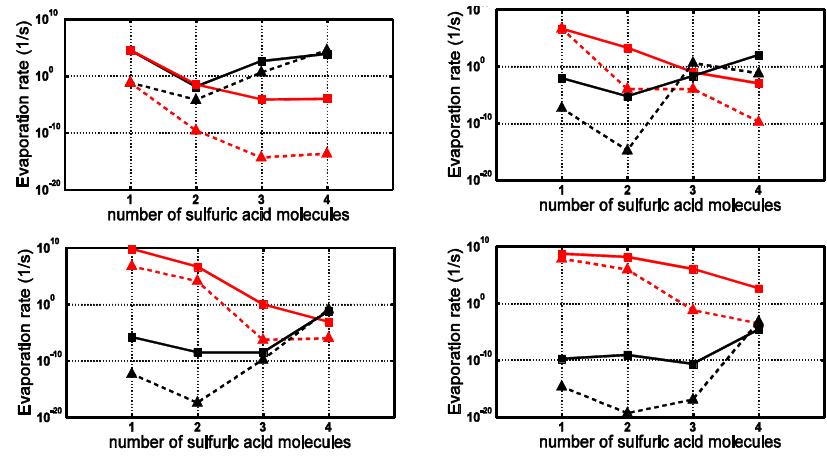
Fig. 2. Evaporation rates of acid (black lines) and base molecules (red lines) from ammonia (solid lines) and DMA (dashed lines) containing clusters. The top left, top right, bottom left, and bottom right panels give the results for 1, 2, 3, and 4 base containing clusters, respectively.